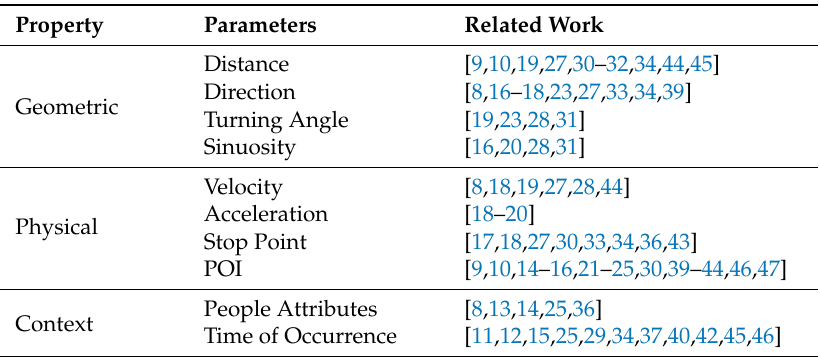
Table 2. Classification of parameter-based previous